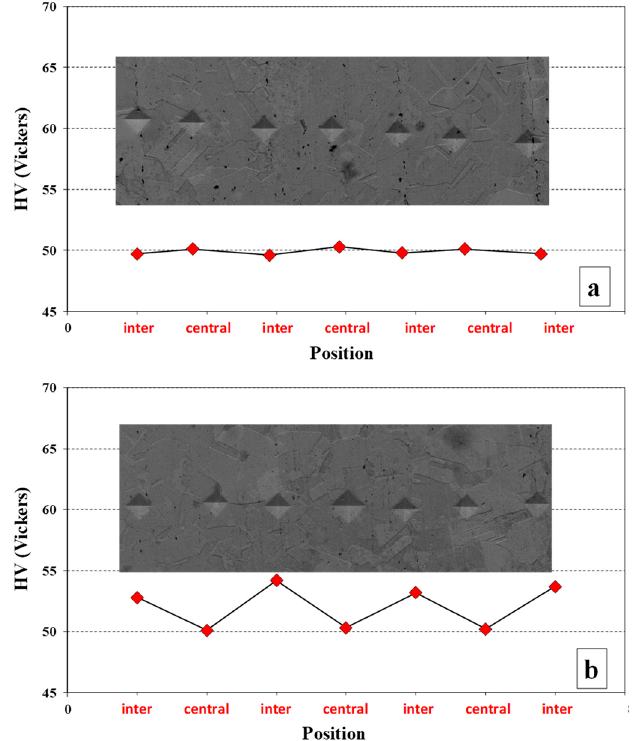
Figure 10. Transvesre Hardness distribution across the bonding region; ( a ) processing for 90 min at 935 ◦ C, ( b ) processing for 90 min at 1000 ◦ C (inter: interlayer between the foils, central: the central 935 °C, ( b ) processing for 90 min at 1000 °C (inter: interlayer between the foils, central: the central point of the foil along its point of the foil along its thickness).